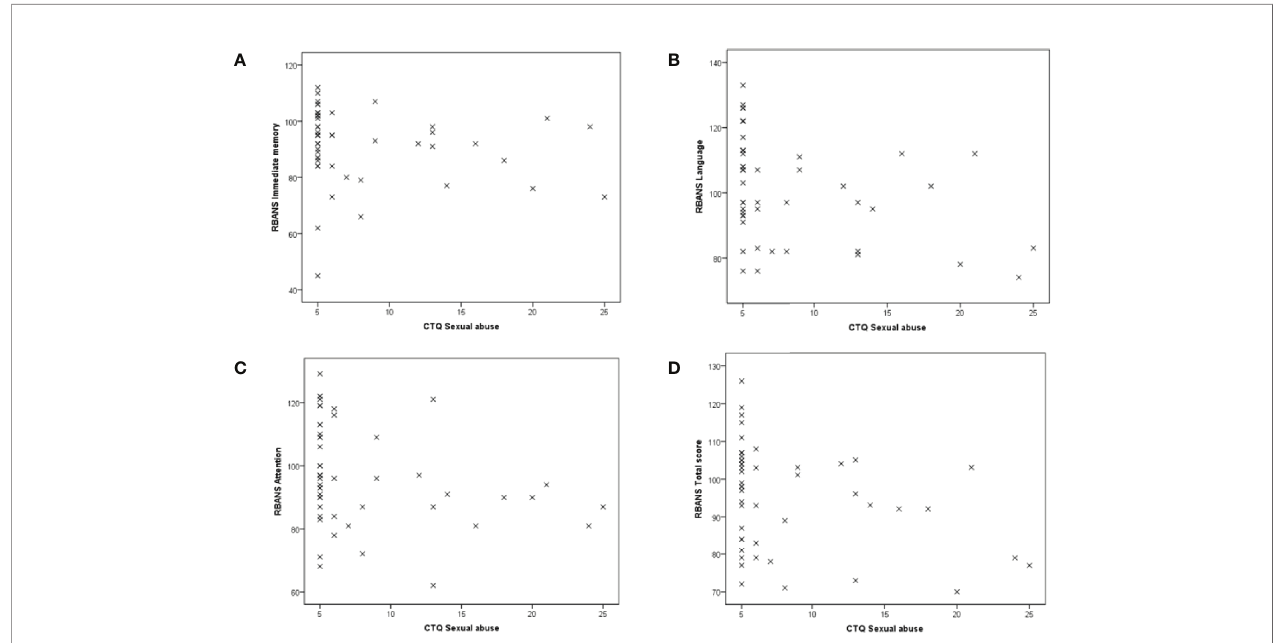
FIGURE 1 | Scatterplot of association between childhood sexual abuse and cognitive functions in patients. Associations of CTQ sexual abuse scores with (A) immediate memory, (B) language, (C) attention, and (D) total score of RBANS. CTQ, Childhood Trauma Questionnaire; RBANS, Repeatable Battery for the Assessment of Neuropsychological Status.